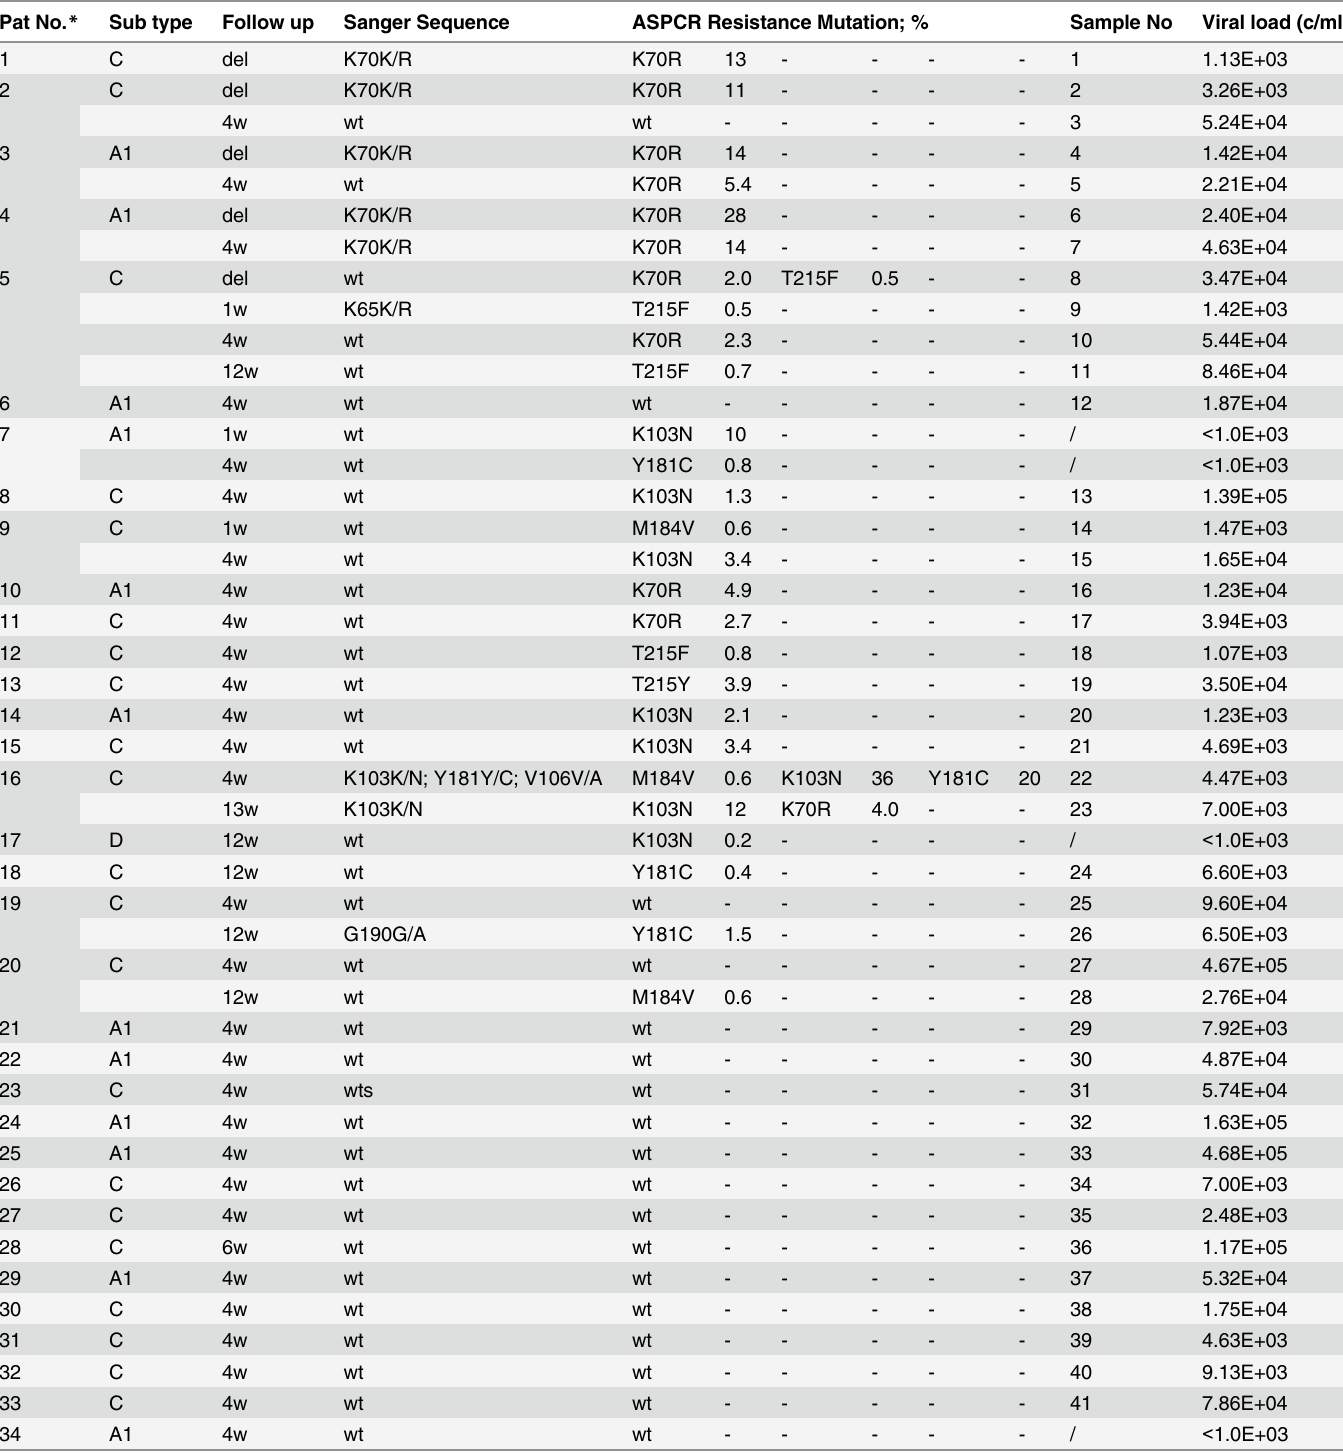
Table 1. Samples included into the